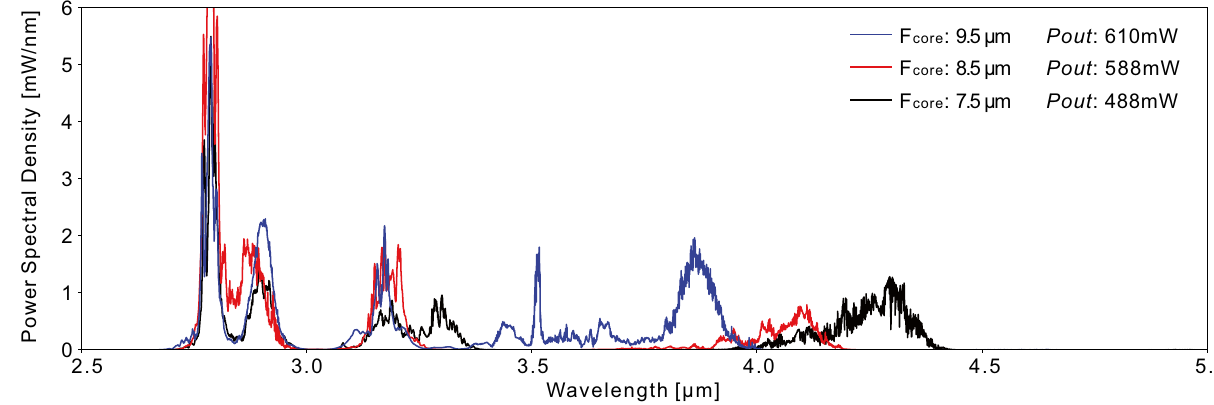
Figure 6. Power spectral density for three different fiber core diameters. All curves were taken at 15.2 W of incident pump power. The different output powers result from the increasing splice losses caused by the fiber dimension mismatch as the core size is reduced.